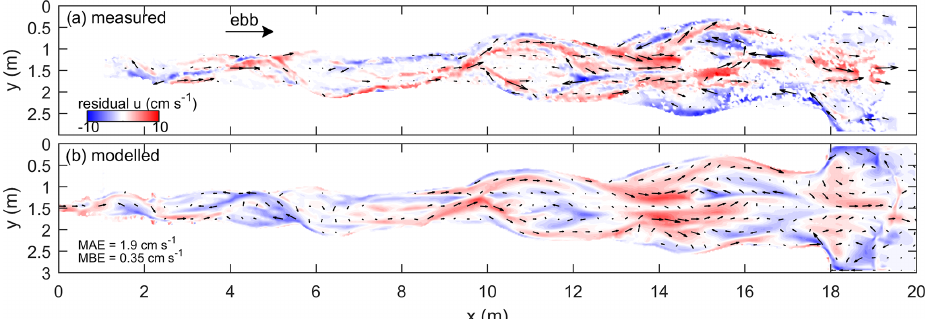
Figure 9. Residual surface flow velocity maps show similar spatial flow patterns and magnitudes between (a) the measured data and (b) model output, apart from the upstream 6m. This upstream region was underseeded with PIV particles, which resulted in wrongly mea- sured flow velocities. Therefore, computation of the mean absolute/bias errors was done for x > 6m.